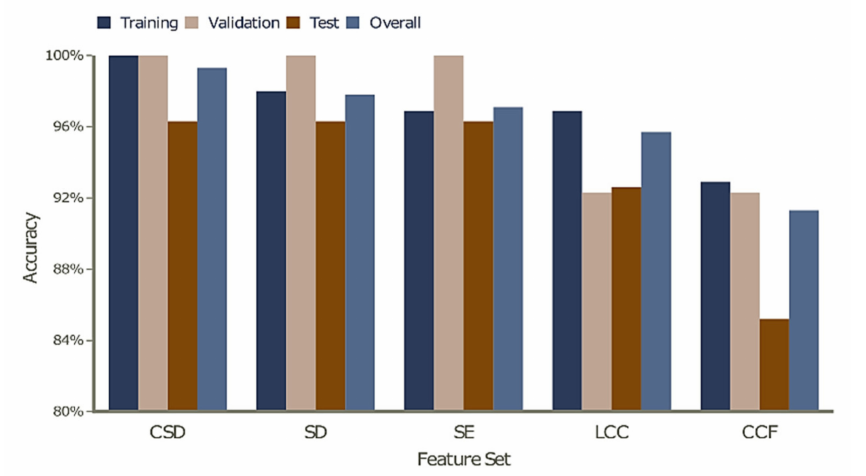
Figure 22. Performance comparison of ANN trained with different numerical indices (CSD, SD, SE, LCC, and